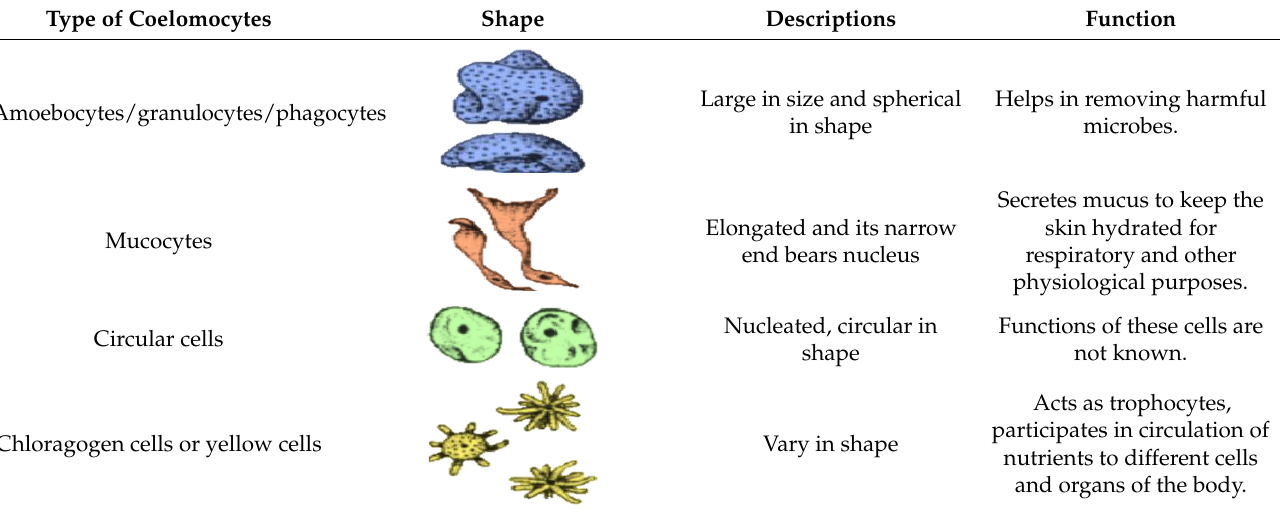
different cells and organs of the body.